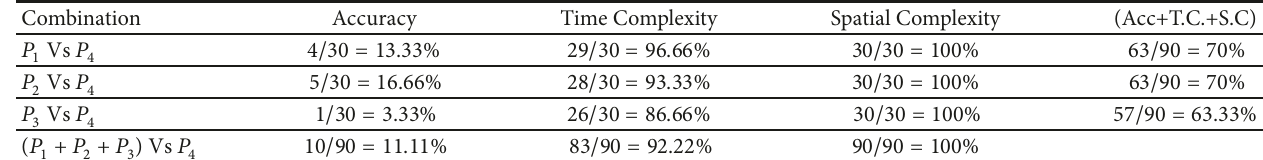
Table 7: Statistically significant differences in each dimension for all HPO across all 𝐷 𝑖 of MLP for each comparison between 𝑃 𝑗 (𝐷 𝑖 ) and 𝑃 (𝐷 ) and the total 4 𝑖